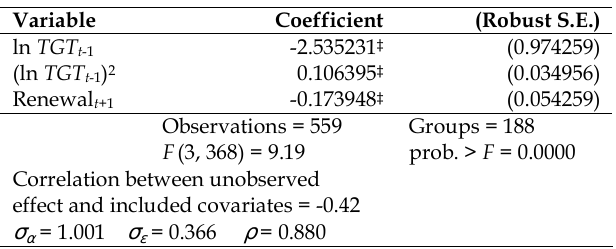
Table 3. Results from a FE model for infrastructure maintenance costs, lagged traffic